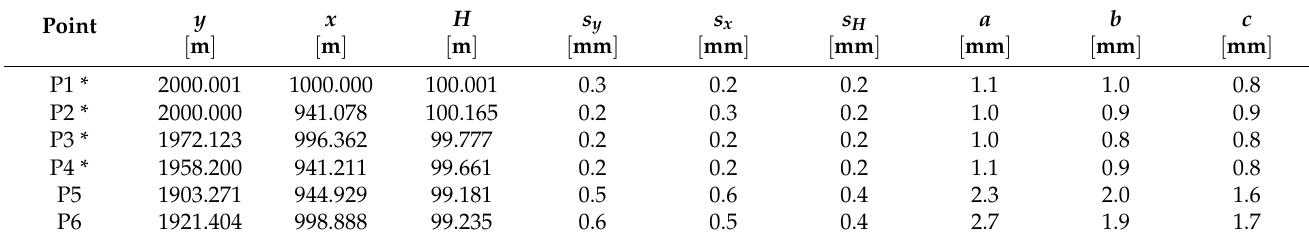
Table 2. Network adjustment results with corresponding quality criteria parameters: standard deviations of the coordinates (cid:0) (cid:1) s y , s x , s H ; and semi-axes of the 95% absolute confidence error ellipsoids ( a , b , c ) .